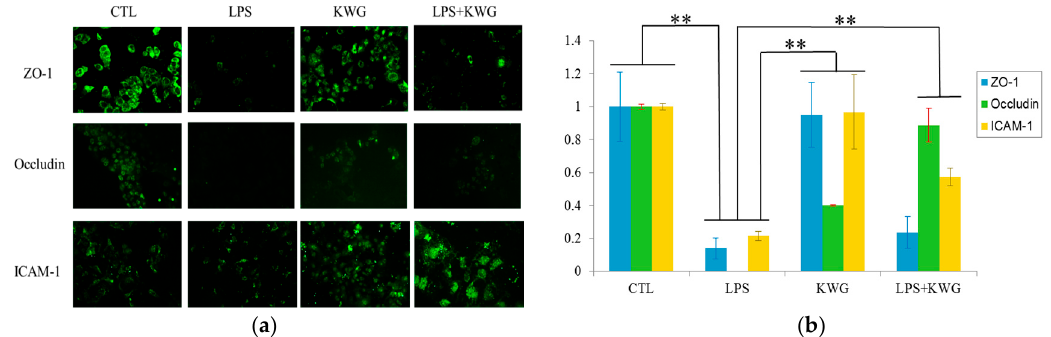
Figure 5. KWG upregulated the intercellular tight junction proteins’ expression. ( a ) Caco-2 cells were treated with control (CTL), LPS, KWG or LPS + KWG for 24 h, intercellular junction proteins including zonula occludens (ZO)-1, Occludin and intercellular adhesion molecule (ICAM)-1 were detected by the immunofluorescence method (magnification: 200). ( b ) Relative protein expressions were analyzed by Image-pro Plus software. The experiments were repeated three times and representative pictures were shown. ** p < 0.01.